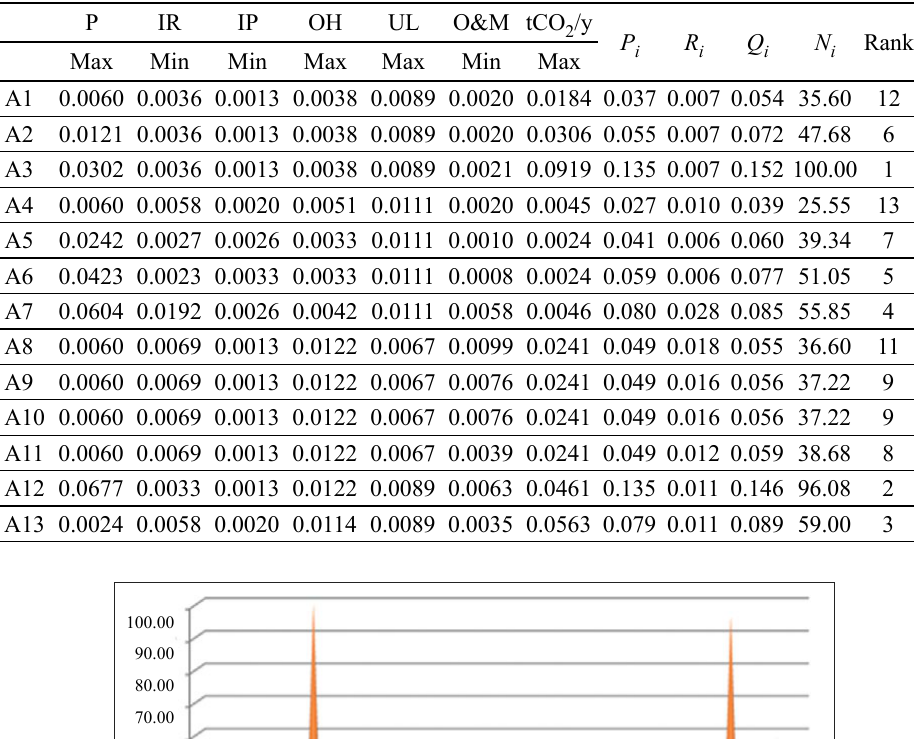
Table 8. The utility degree and ranking results of thirteen alternatives